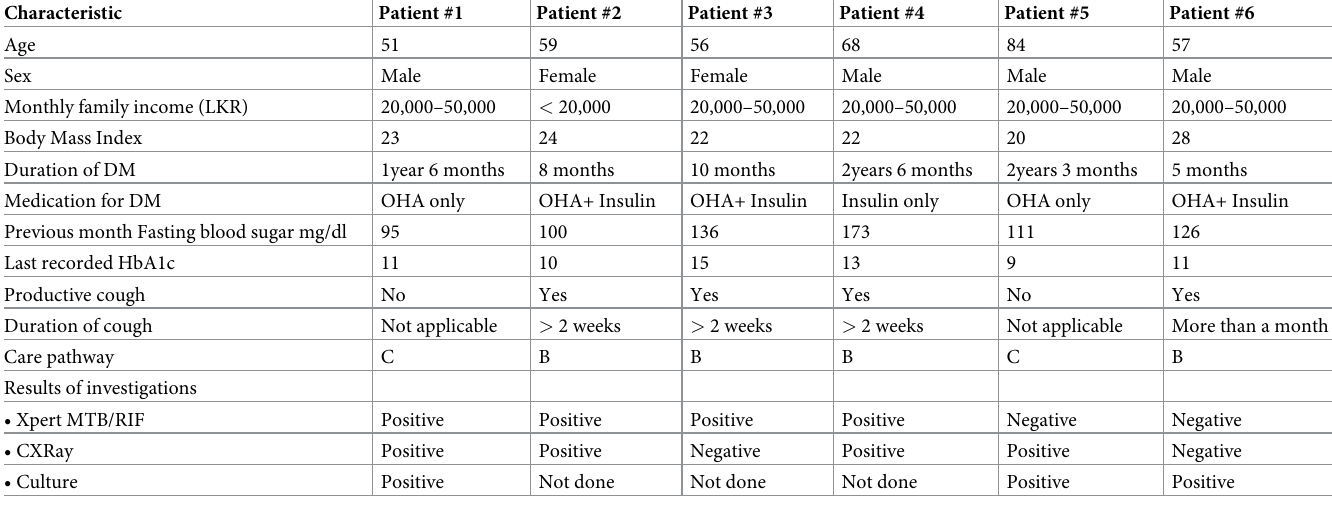
Table 4. Distribution of socio-demographic and illness-related characteristics of patients with pulmonary tuberculosis detected.